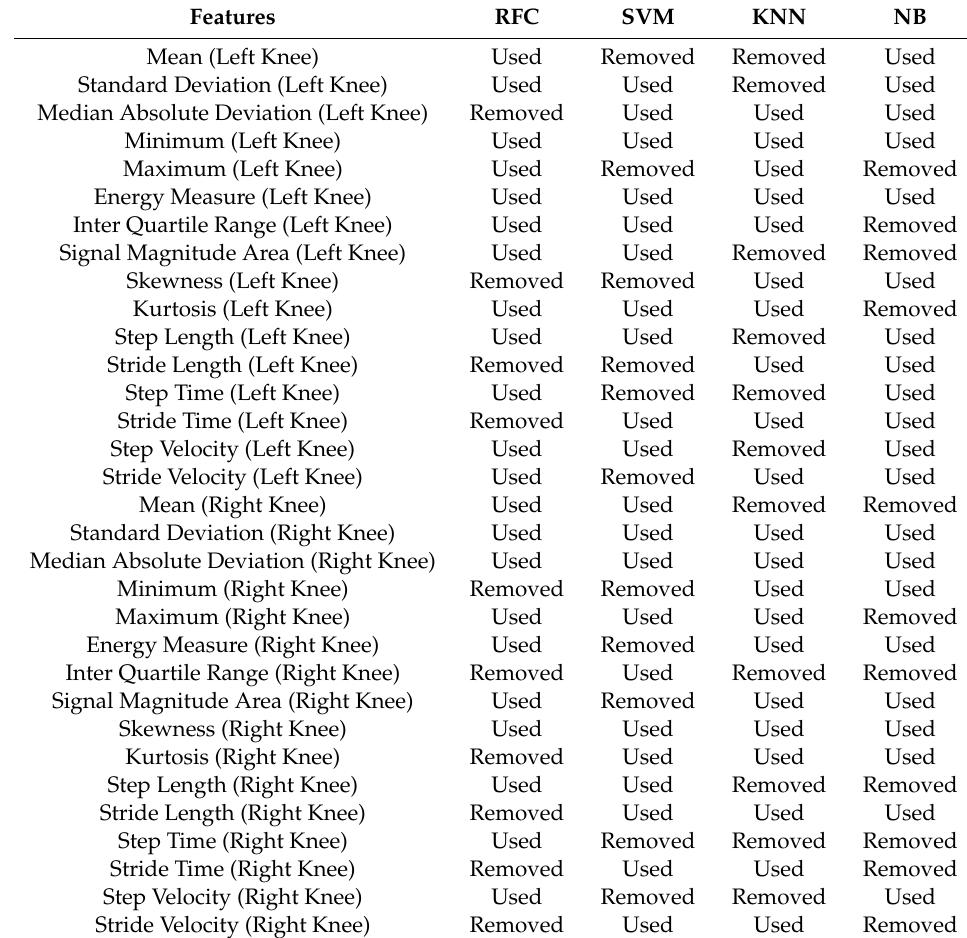
Table 6. Feature selection for all the